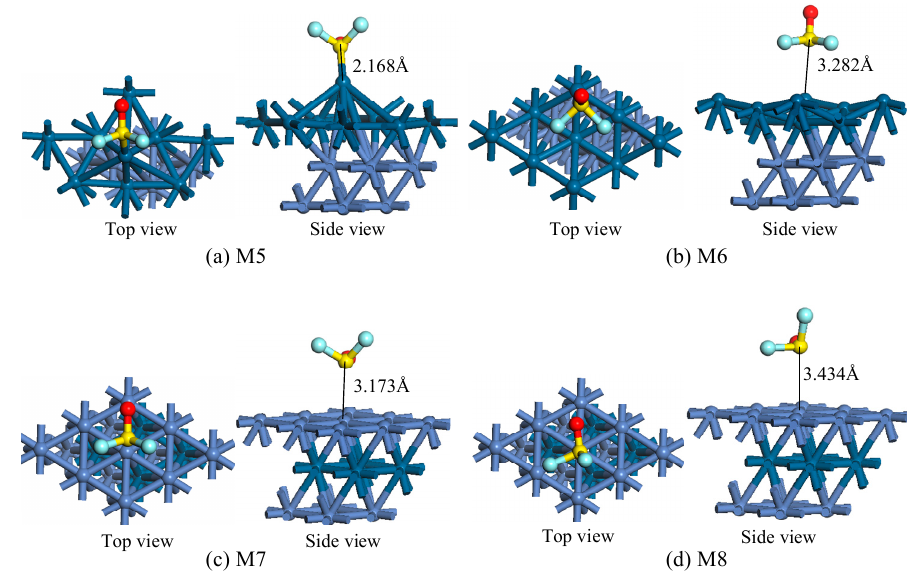
Figure 5. The top and side views of adsorption structures. ( a , b ) SOF 2 adsorption on Pt-Ni(111) surface for M5 and M6 structures, ( c , d ) SOF 2 adsorption on Ni-Pt-Ni(111) surface for M7 and M8 structures. Table2. Theadsorption parametersof SOF 2 adsorbedby Ni(111), Pt-Ni(111), and